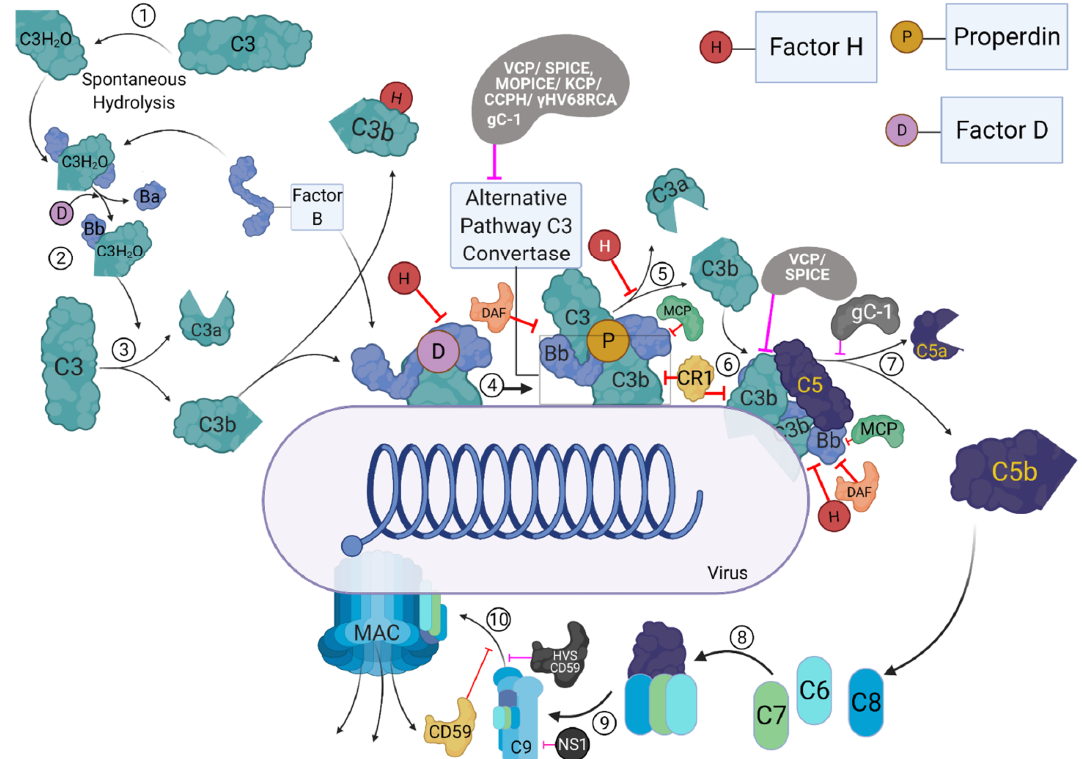
Figure 2. The activation and regulation of the alternative pathway and its targeting by virally encoded molecules. During the process of alternative pathway (AP), native C3 by H 2 O is spontaneously hydrolysed, resulting in the formation of C3b like C3 [C3(H 2 O)] (1). C3(H 2 O) can bind to factor B (FB), and upon cleavage by factor D (FD), which forms the initial